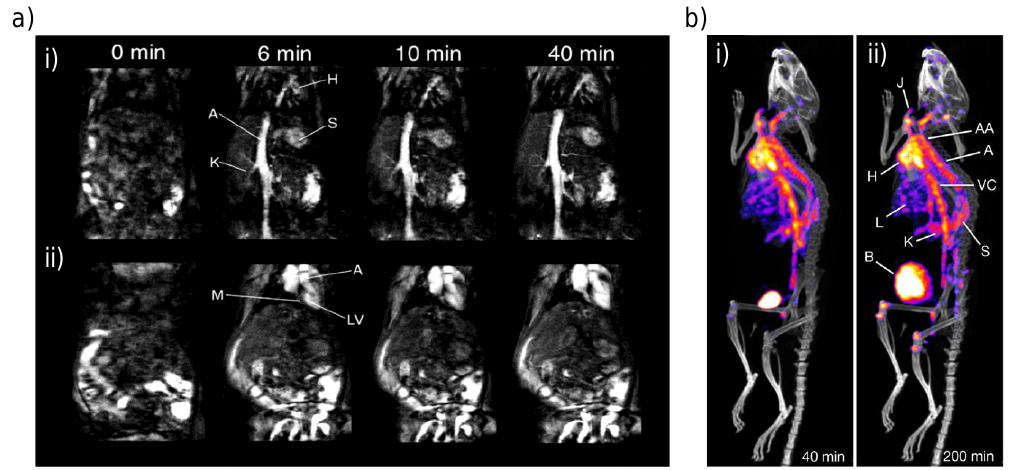
Figure 5. ( a ) In vivo MRI studies with PEG(5)-BP-USPIO: T 1 -weighted images showing the increase in signal from blood in the vessels and the heart (ii) at different time points ( t = 0 min, pre-injection). ( b ) Maximum intensity projection SPECT-CT images after i.v. injection of radiolabelled (99mTc) PEG(5)-BP-USPIO at the first (i, 40 min) and last (ii, 200 min) time points. Labels: H = heart, S = spleen, K = kidney, A = aorta, M = myocardium, LV = left ventricle, J = jugular vein, AA = aortic arch, VC = vena cava, L = liver, B = bladder. Modified and reproduced with permission from [118].